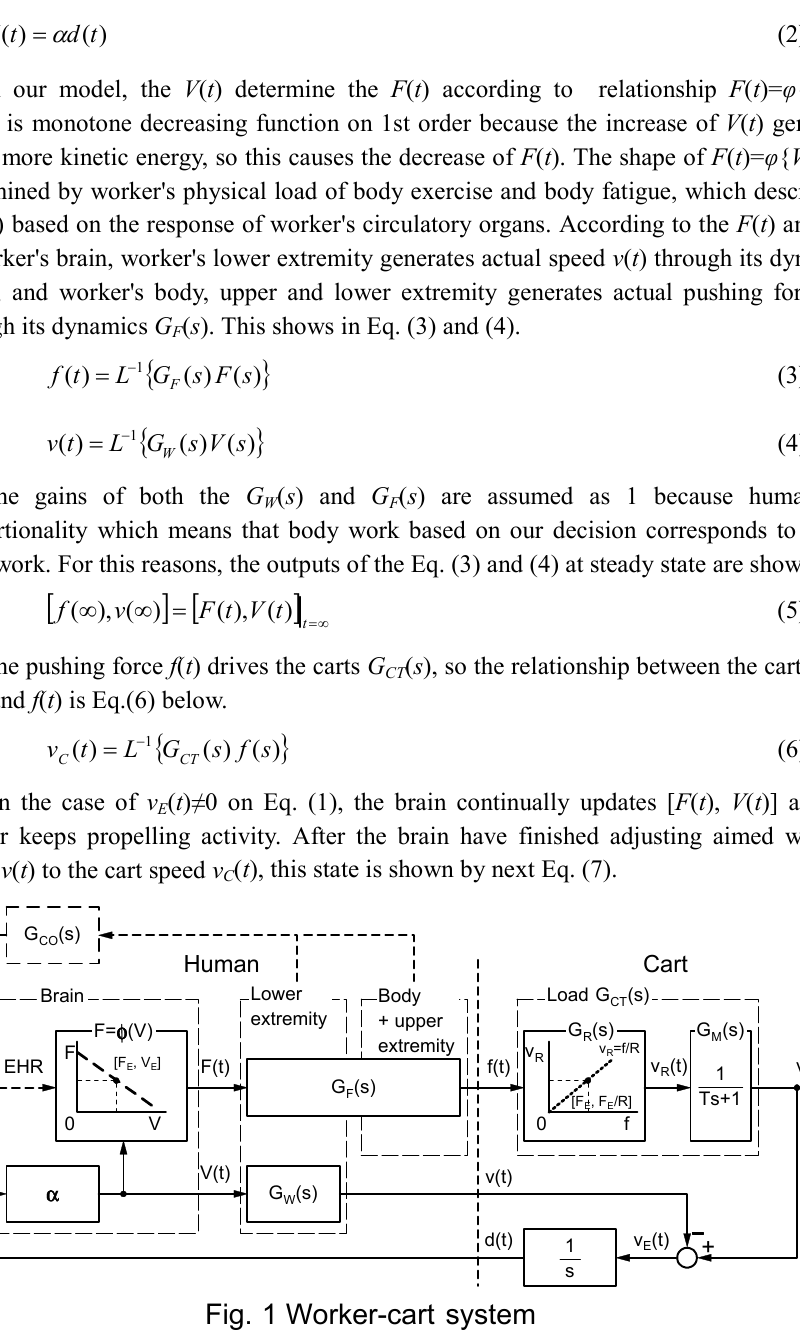
Fig. 1 Worker-cart system